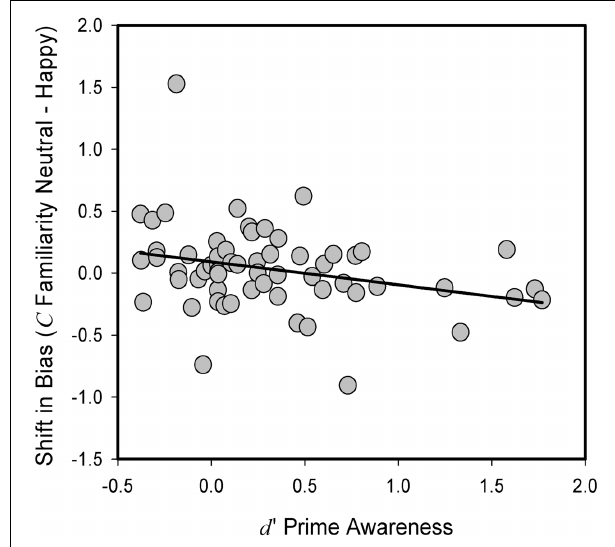
FIGURE 3 | Relationship between prime awareness ( d (cid:2) ), as measured in prime-discrimination task, and difference in criterion location ( C ) between Happy and Neutral trials for “Know” responses in recognition decisions in Experiment 2. Positive priming values reflect a more liberal criterion placement for Happy relative to Neutral prime condition. Dots represent data of individual